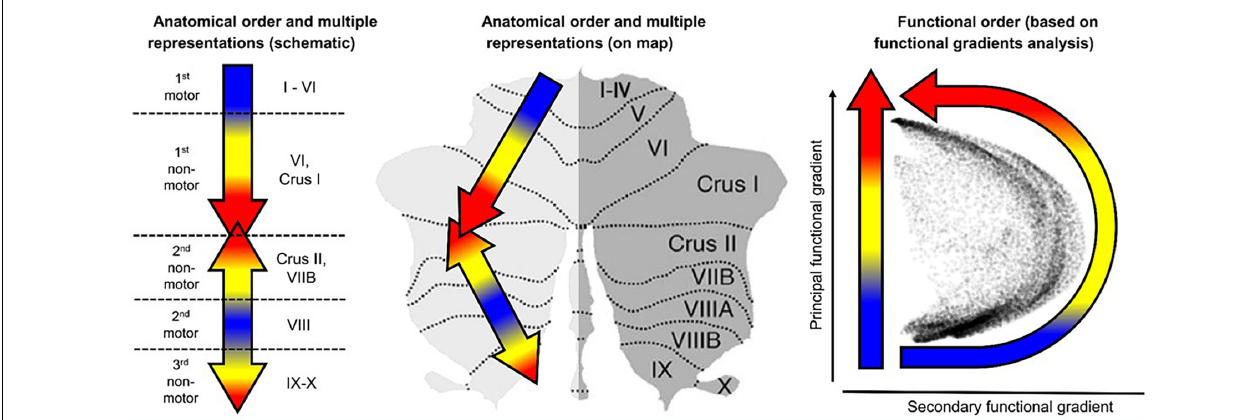
FIGURE 1 | Didactic summary of cerebellar functional anatomy based on human fMRI evidence. Data-driven analyses of cerebellar fMRI indicate three major fundamental poles of cerebellar functional neuroanatomy. ( Left,Center ) Motor processing (blue) is represented twice in each cerebellar cortical hemisphere (lobules I–VI; lobule VIII). Non-motor processes (red and yellow) are represented three times in each cerebellar cortical hemisphere (lobules VI-Crus I; lobules Crus II–VIIB; lobules IX–X). A specific anatomical order is conserved throughout the cerebellar cortex, and propagates from first motor toward first non-motor representation (i.e., from lobules I–VI to Crus I), from second motor toward second non-motor representation (i.e., from lobule VIII to Crus II), and from second motor toward third non-motor representation (i.e., from lobule VIII to lobule IX/X). ( Right ) The principal axis of macroscale functional organization in the cerebellar cortex progresses from motor, to attentional/executive, to default-mode processing. This progression is captured in the anatomical order of cerebellar functional territories as shown in the center and right panels, and also revealed by a data-driven analysis of functional gradients in the cerebellar cortex based on resting-state functional connectivity between cerebellar cortical areas (After Guell and Schmahmann, 2020; reproduced with permission).